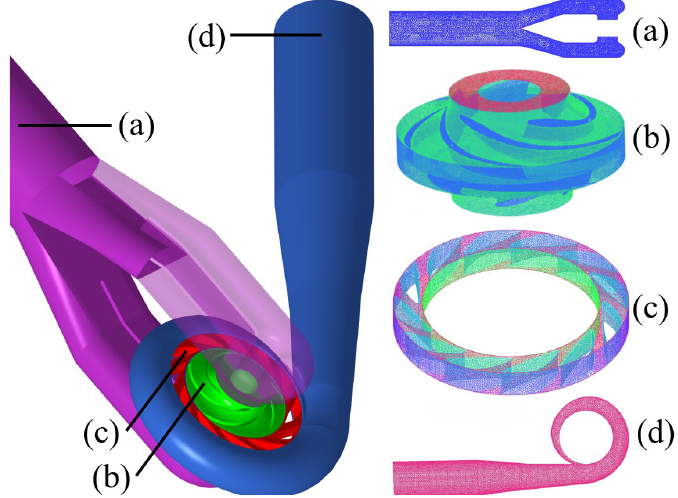
Figure 1. Pump model and mesh: ( a ) annular suction chamber, ( b ) impeller, ( c ) diffuser, ( d ) volute.